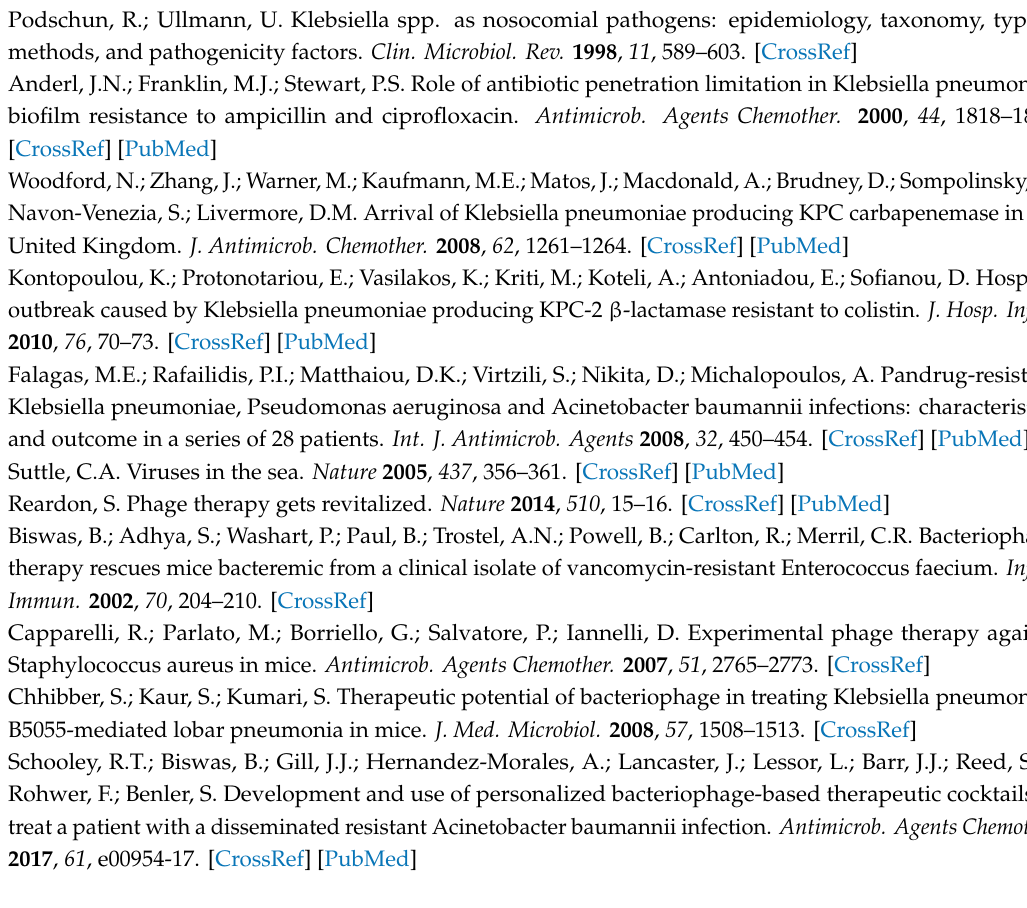
Figure S1: Genomic structure of phage 117 (A) and phage 31 (B). The genome map was performed using the CLC Main Workbench, version 12.0 (CLC bio, Qiagen, Denmark). Arrows represent predicted ORFs, the direction of the arrow represents the direction of transcription; Figure S2: Analysis of phage stabilities in the absence of host in cell-free urine spent supernatant. Culture was inoculated at 37 ◦ C in a shaking incubator for 8 h. Error bars represent the actual ranges of data from all experiments carried out in